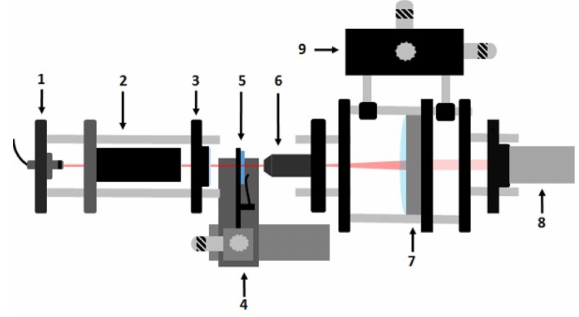
Figure 2. Schematics of out metalens characterization setup. 1) 1064 nm diode laser, 2) Glan-Thompson polarizer, 3) λ/ 4 plate, 4) motorized XYZ and rotation stage with sample holder, 5) sam- ple, 6) 20 × objective, 7) f = 150 mm lens, 8) CCD camera, 9) XYZ